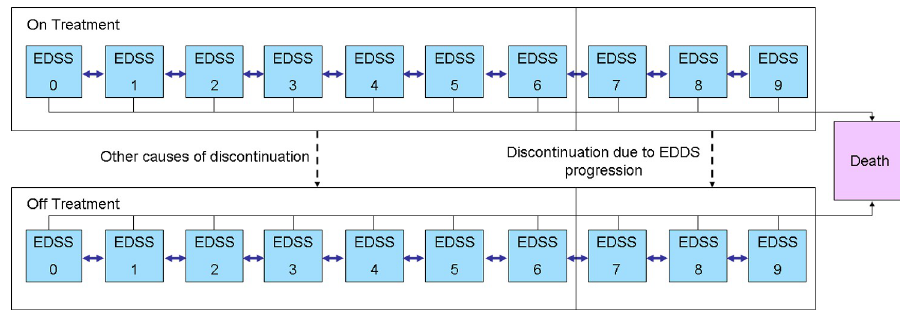
Fig 1. Cost-effectiveness model